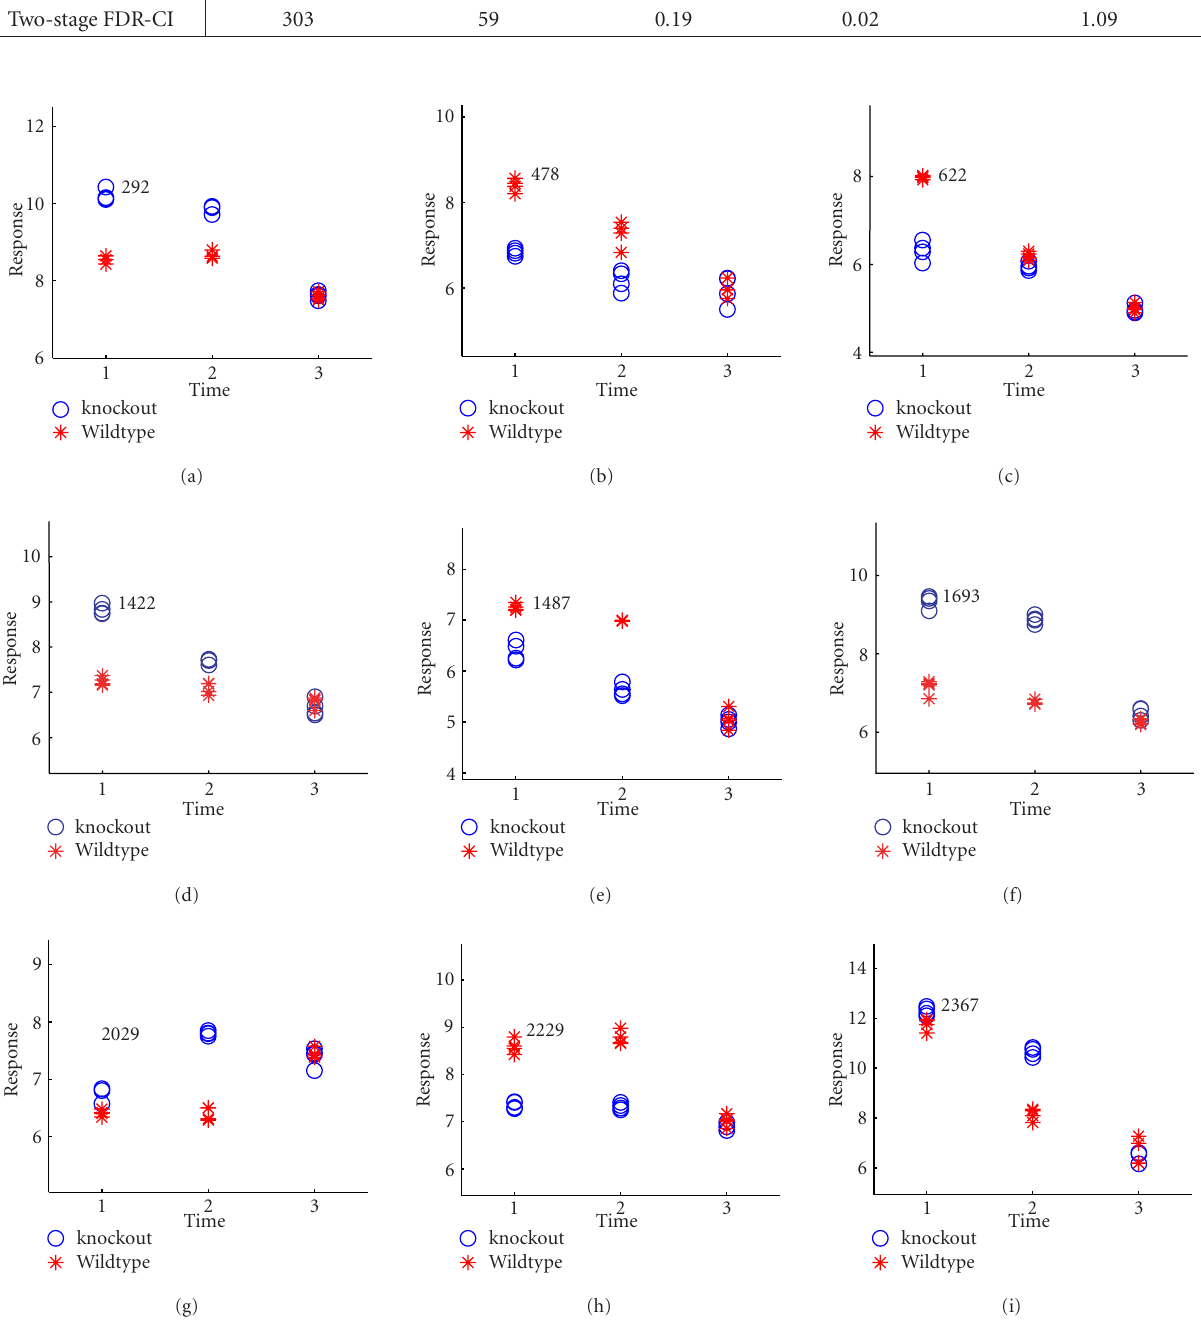
Figure 5: Gene profiles of nine of the di ff erentially expressed genes discovered using the proposed two-stage FDR-CI procedure with con- straints on level of significance α = 0 . 2 and minimum foldchange fcmin = 1 . 0. Knockout “ ◦ ” and Wildtype “ ∗ ” are as indicated, and the numbers on each panel denote gene indices (related to the positions of the gene probes on the